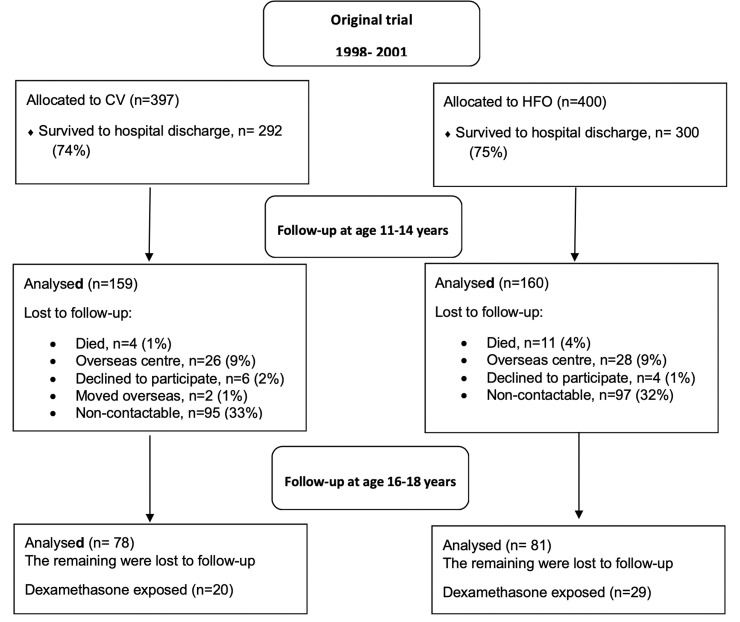
United Kingdom Oscillation Study Consolidated Standards Of Reporting Trials (CONSORT) flow diagram.